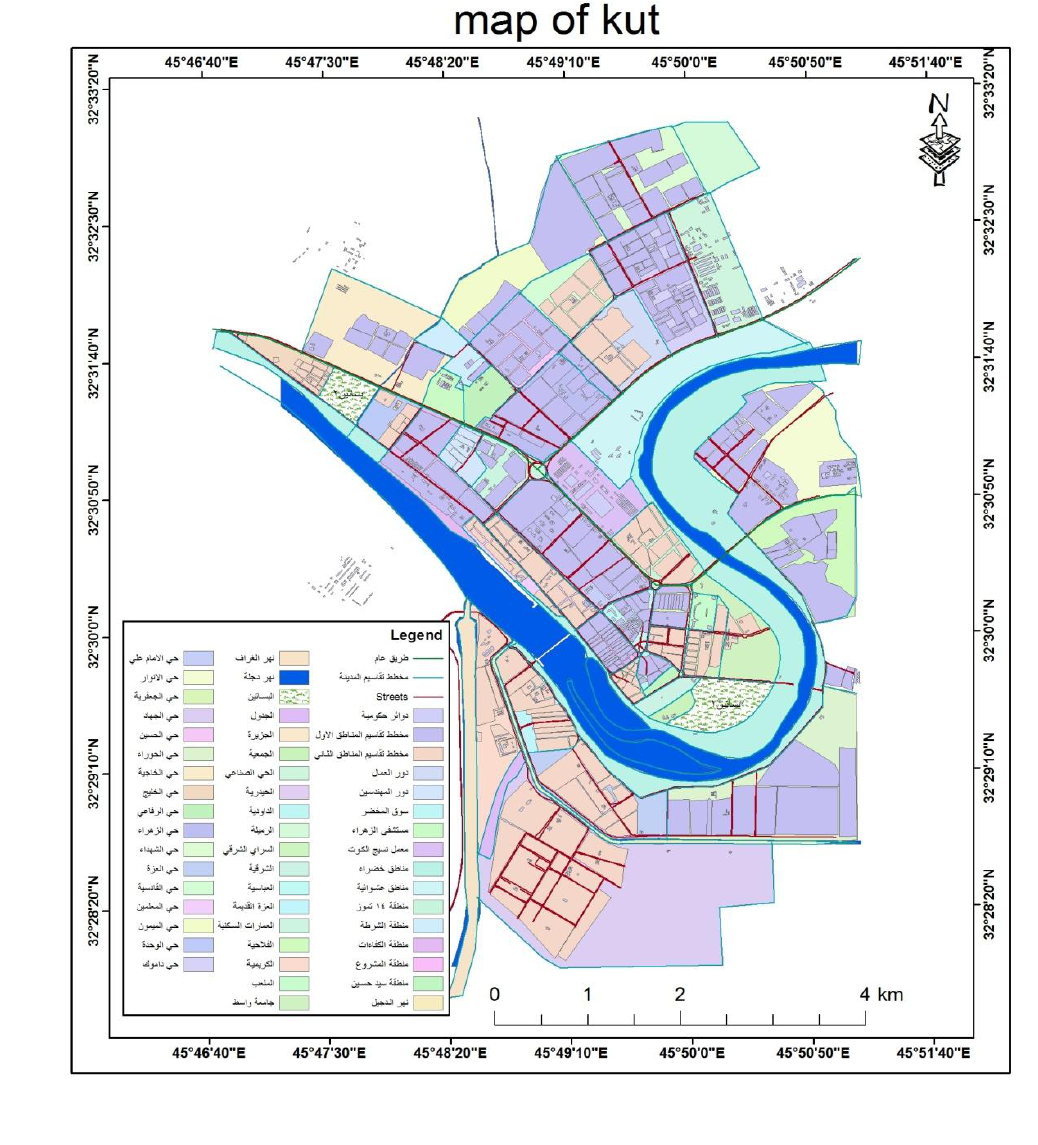
Fig.21: Producing update map of Kut which draw from high resolution satellite image using layers from